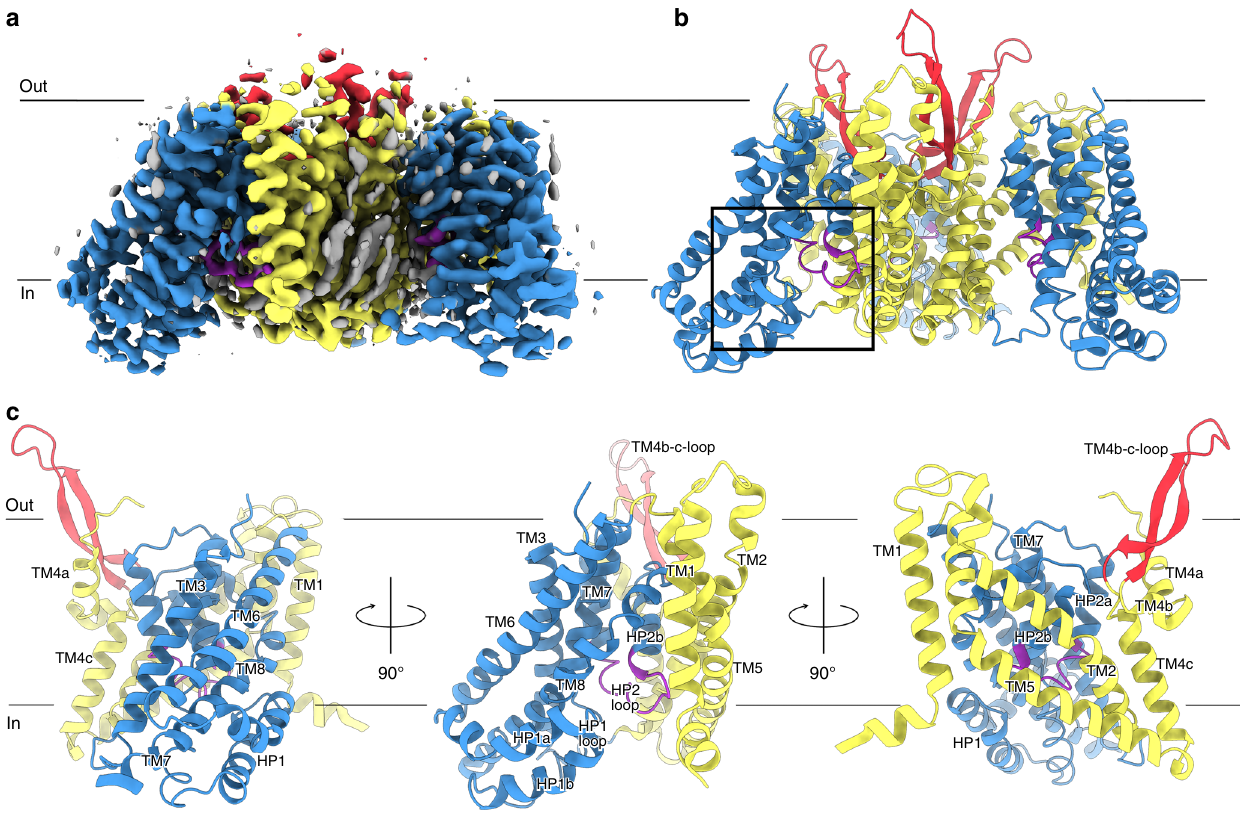
Fig. 2 Inward-open structure of ASCT2 C467R . Cryo-EM map of ASCT2 C467R obtained in presence of TBOA at 3.6 Å resolution ( a ) and respective model shown as ribbon ( b ). c Protomer of ASCT2 with labelled structural elements is shown as ribbon, rotations are indicated. The scaffold domains are coloured in yellow, the extracellular antenna in red, the transport domains in blue, the HP2 loop in purple, and non-protein densities in grey (see also Supplementary Fig. 7). The membrane boundary is indicated and the location of the substrate binding site as shown in Fig. 3 is highlighted by a black rectangle in panel